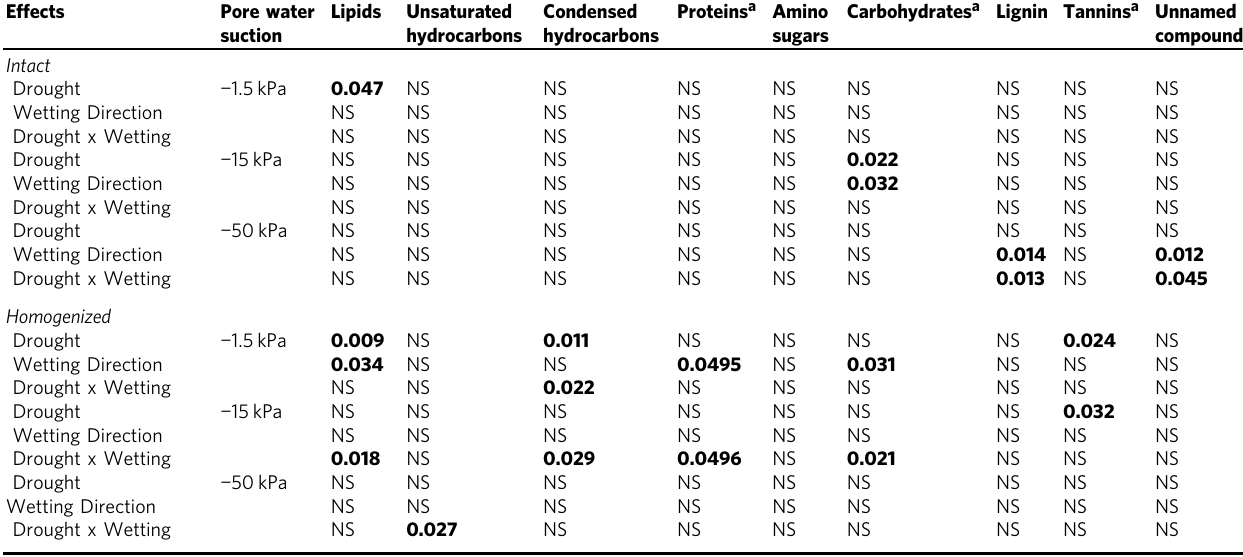
Table 1 P -values for the main and interactive effects of antecedent drought and wetting direction for molecular compound classes of individual pore water domains collected from intact and homogenized cores